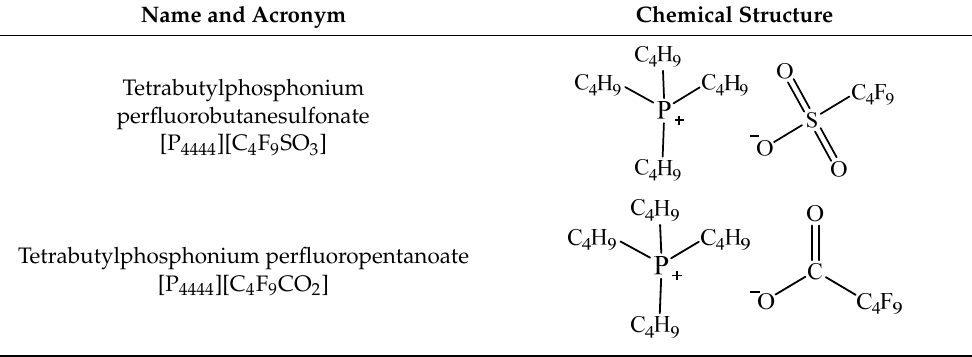
Table 1. Cont. Name and